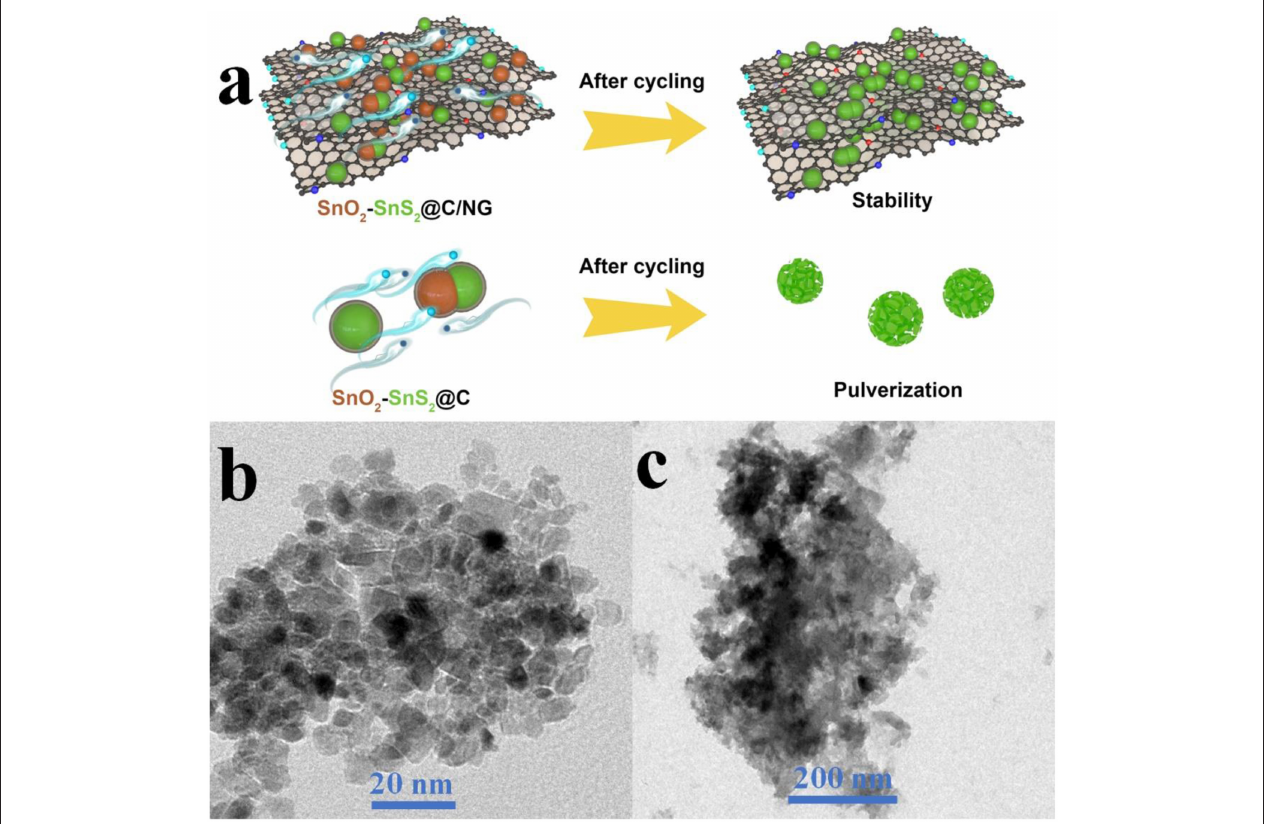
FIGURE 7 | (a) Schematic illustration of the robust structure for SnO 2 -SnS 2 @C/NG and SnO 2 -SnS 2 @C composites. TEM images of (b) SnO 2 -SnS 2 @C/NG and (c) SnO 2 -SnS 2 @C composites after cycling